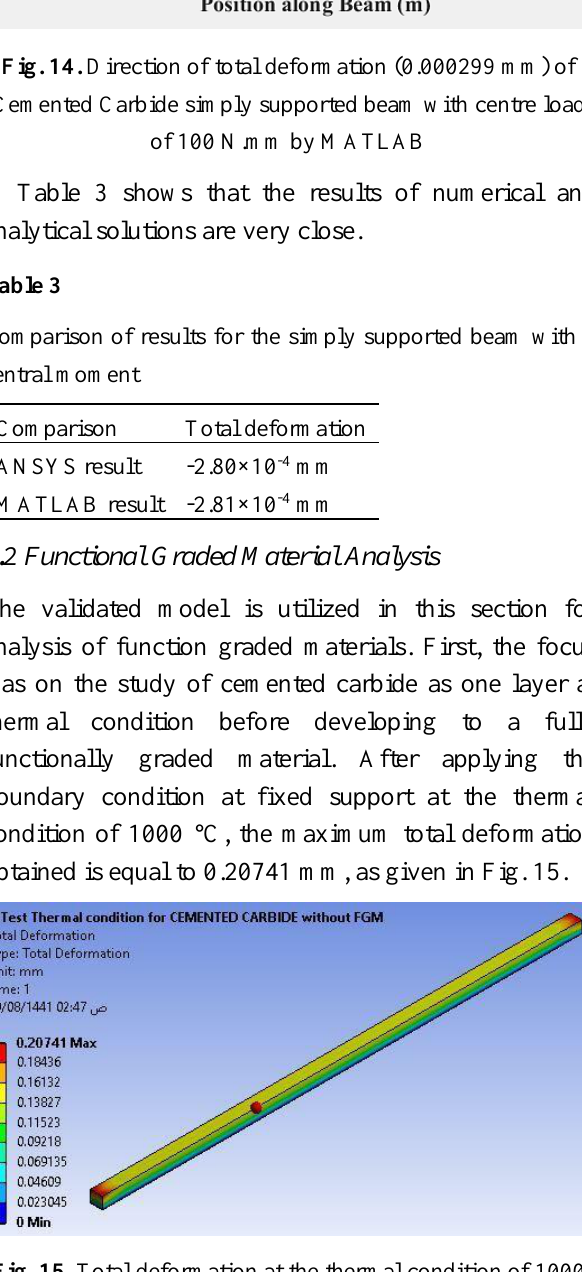
Fig. 15. Total deformation at the thermal condition of 1000 °C. The maximum total deformation produced of 0.2 mm